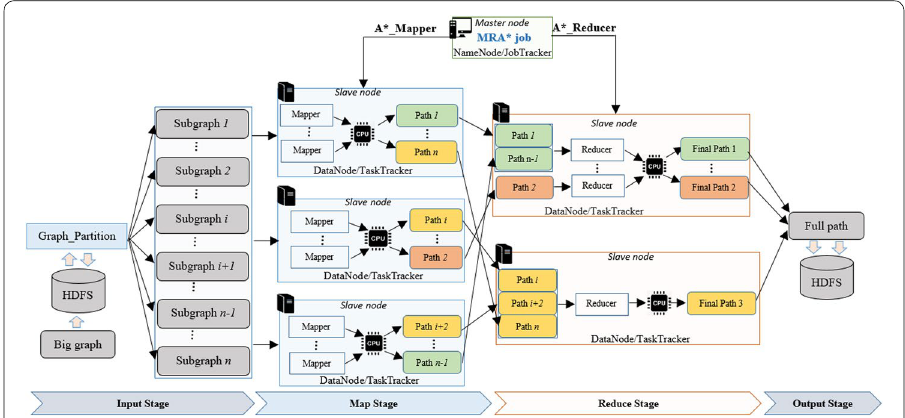
Fig. 3 Overview execution of MapReduce-A*